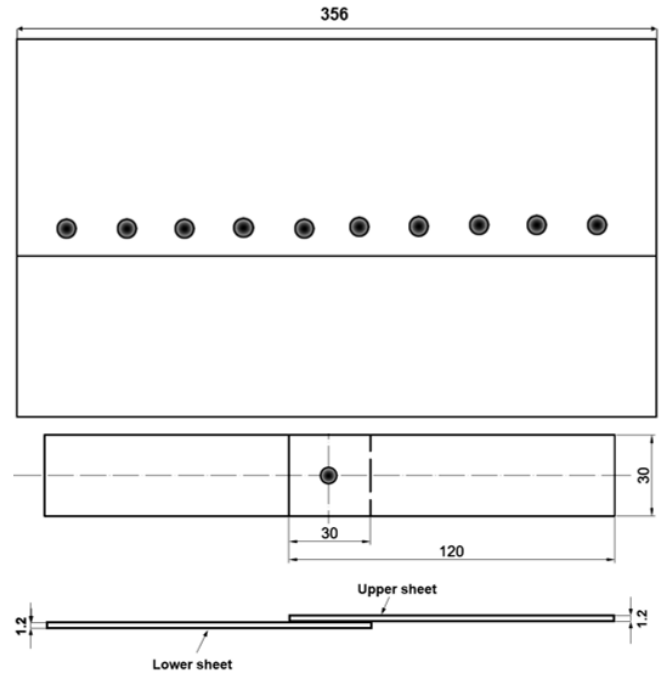
Figure 1. Scheme of sheets and test specimen welded in lap configuration.